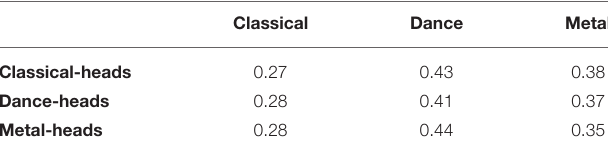
TABLE 2 | Example of Submatrix A showing the average Valence of three genres downloaded by three X-head subgroups. Classical